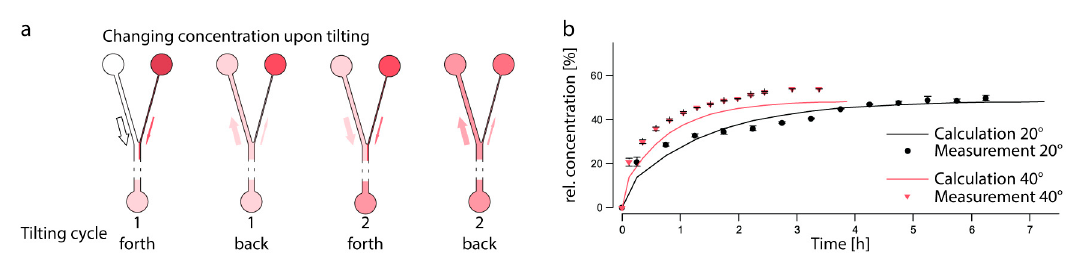
Figure 3: Changing concentrations upon tilting. ( a ) Schematic depicting the unequal flow through the differently sized channels (indicated by arrow thickness) and the changing concentrations within the three reservoirs. ( b ) Experimental assessment of the concentration changes in the main channel and reservoir using amaranth red in the dosing reservoir at tilting angles of 20° and 40°. Measured values generally match the calculations ( n = 3 measurements; data represent average values ±